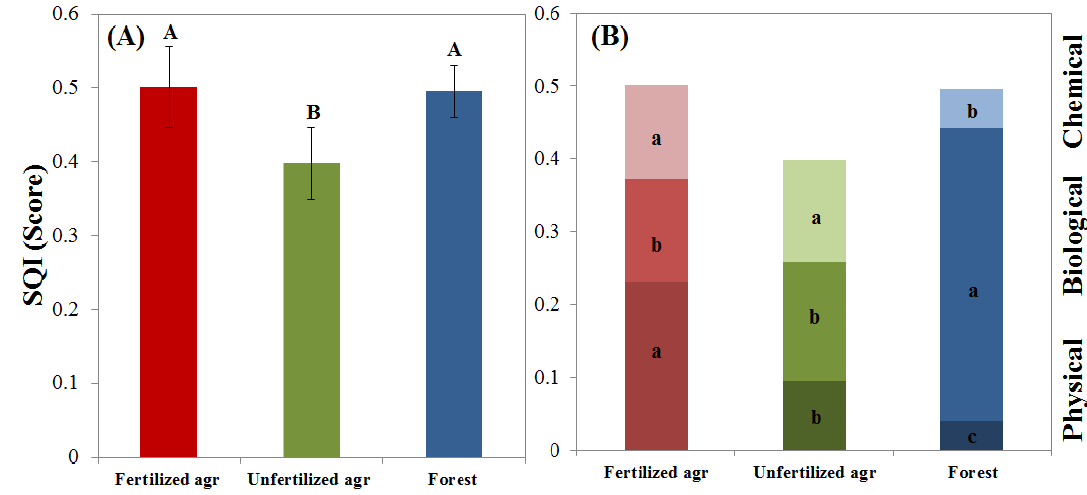
Figure 5. ( A ) Scores of soil quality indices (SQIs) for the three land uses in the Schäfertal site, Germany: Fertilize agriculture field (red color), unfertilized agriculture field (green color), and forest (blue color); and ( B ) the SQI that was calculated by physical, biological, and chemical analyses. Capital letters above the error bars represent significant differences between land uses. Small letters within the columns represent significant differences between soil